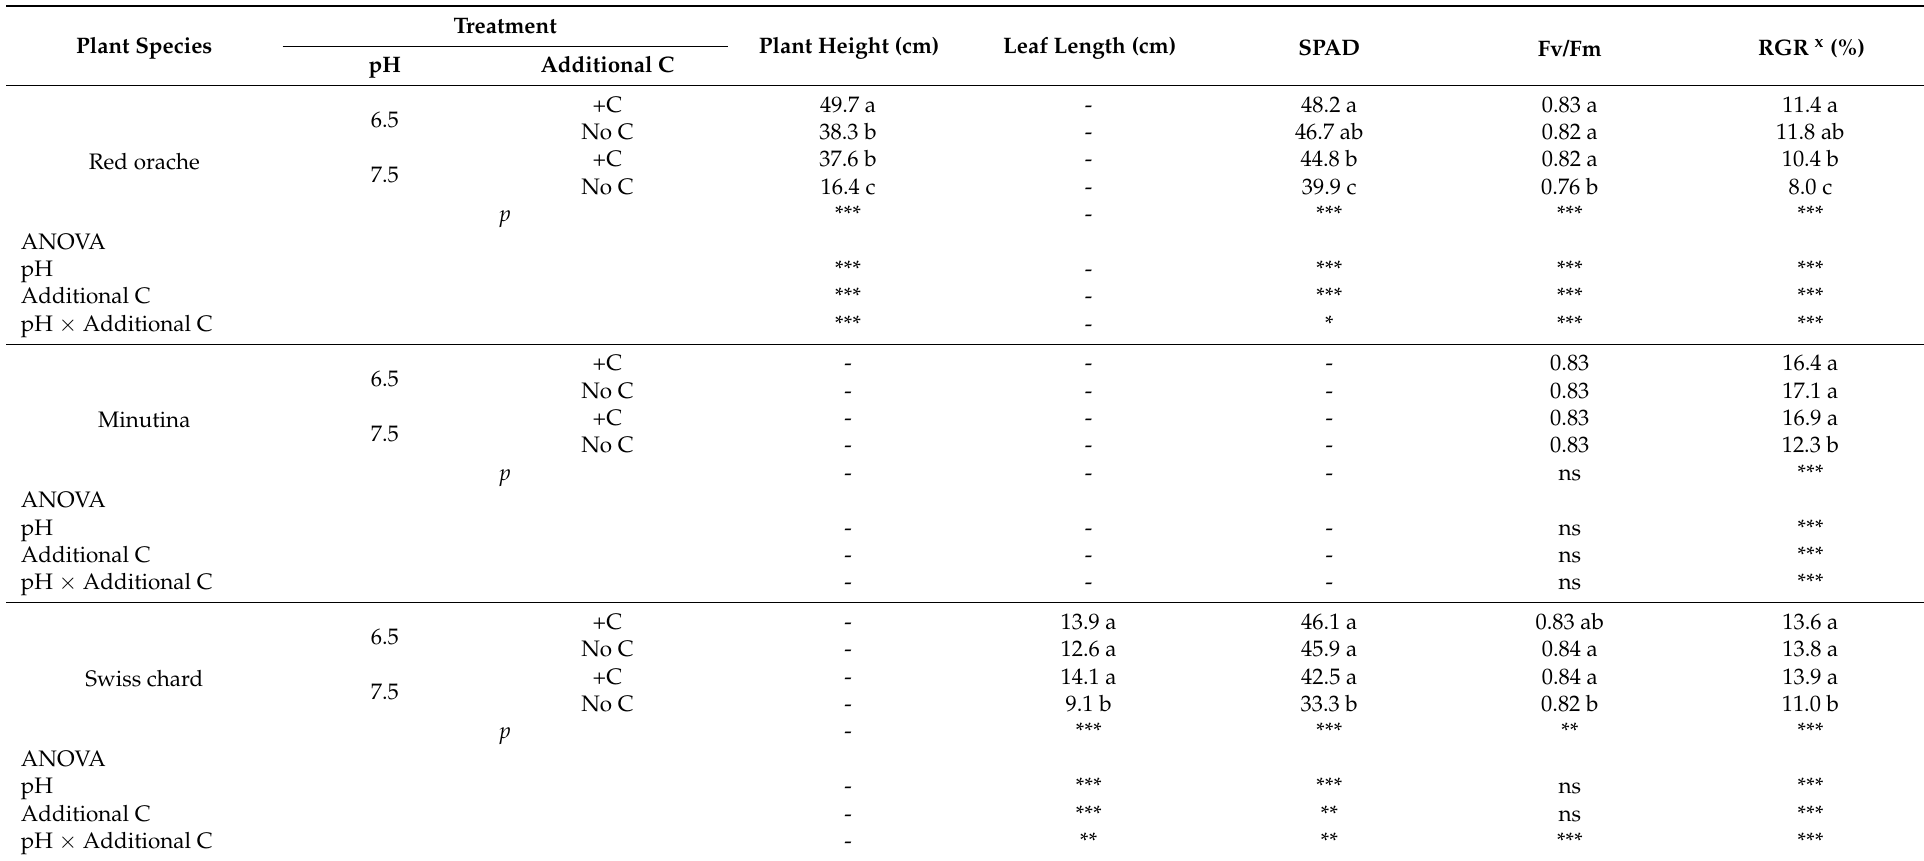
Table 4. Plant growth parameters of red orache, minutina, and Swiss chard in aquaponics under two pH levels with or without additional C in the first harvest. Plant